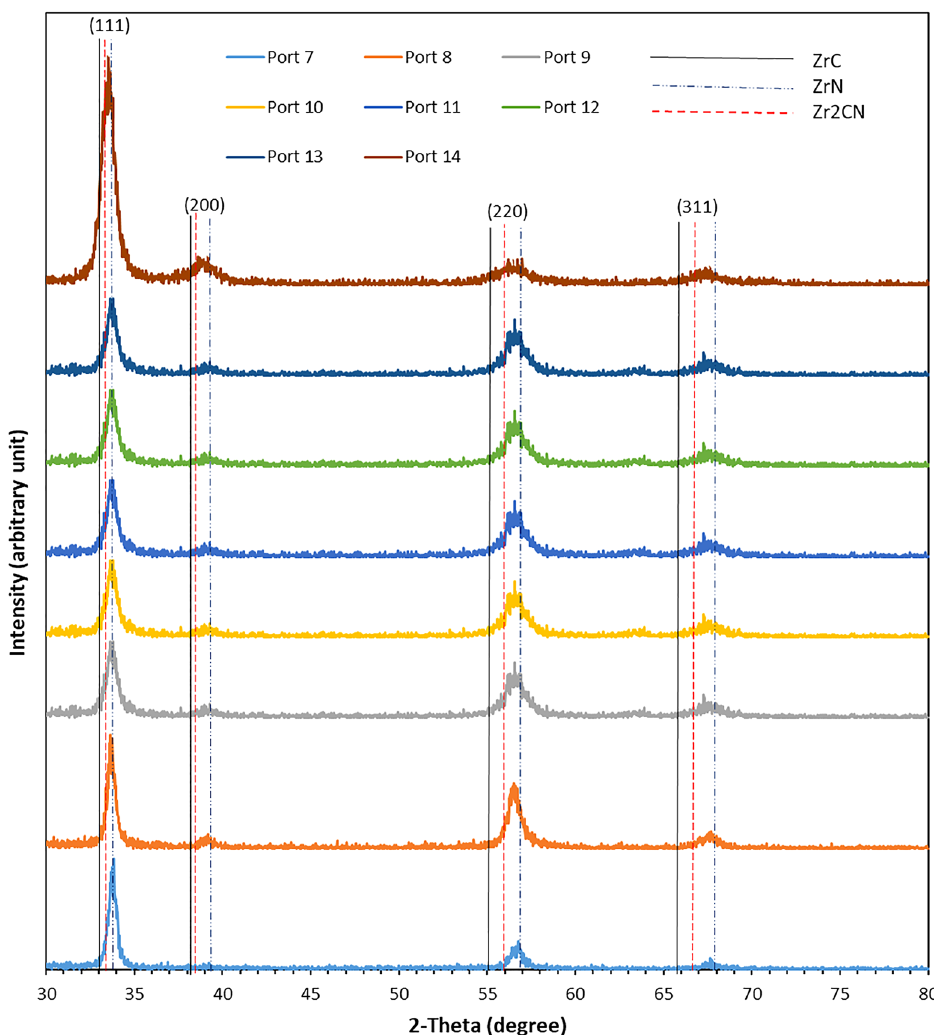
Figure 9. Obtained XRD spectra obtained for (a) PN7, (b) PN8, (c) PN9, (d) P10, (e) PN11, (f) PN12, (g) PN13, and (h) PN14 coatings (the Zr, ZrN and Zr 2 CN coatings compositions are